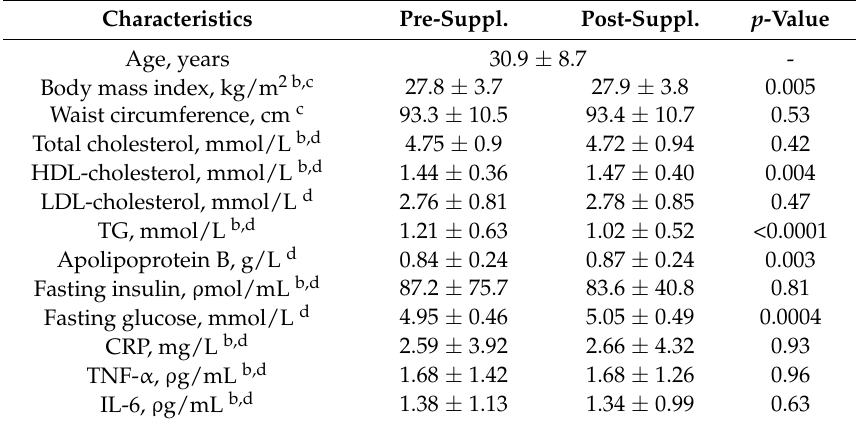
Table 2. Characteristics of the study sample pre- and post-supplementation ( n = 210).